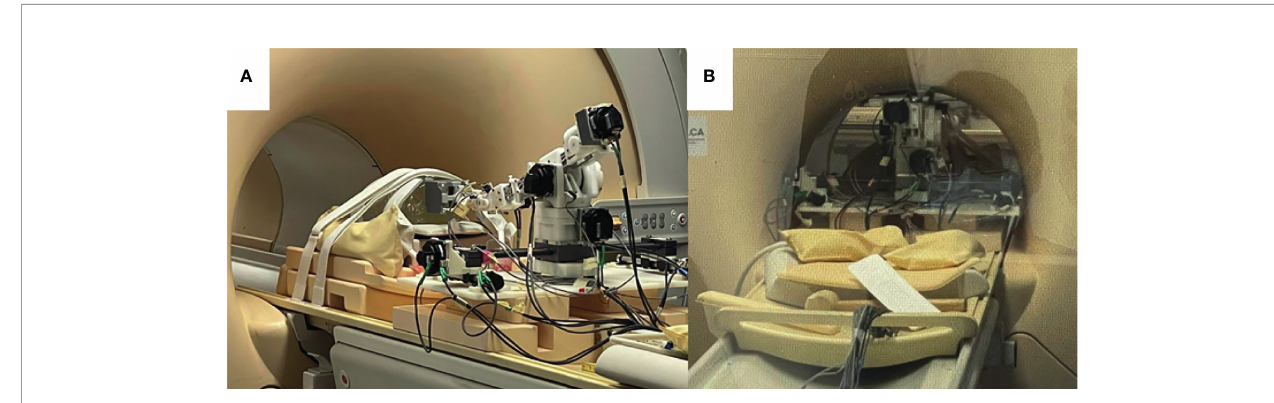
FIGURE 4 | Robot setup in MRI bore. (A) Robot in place on MR bed with a z-frame fi ducial phantom attached to the front of the extension joint; (B) Robot advanced into the bore of the MRI with phantom at isocenter.